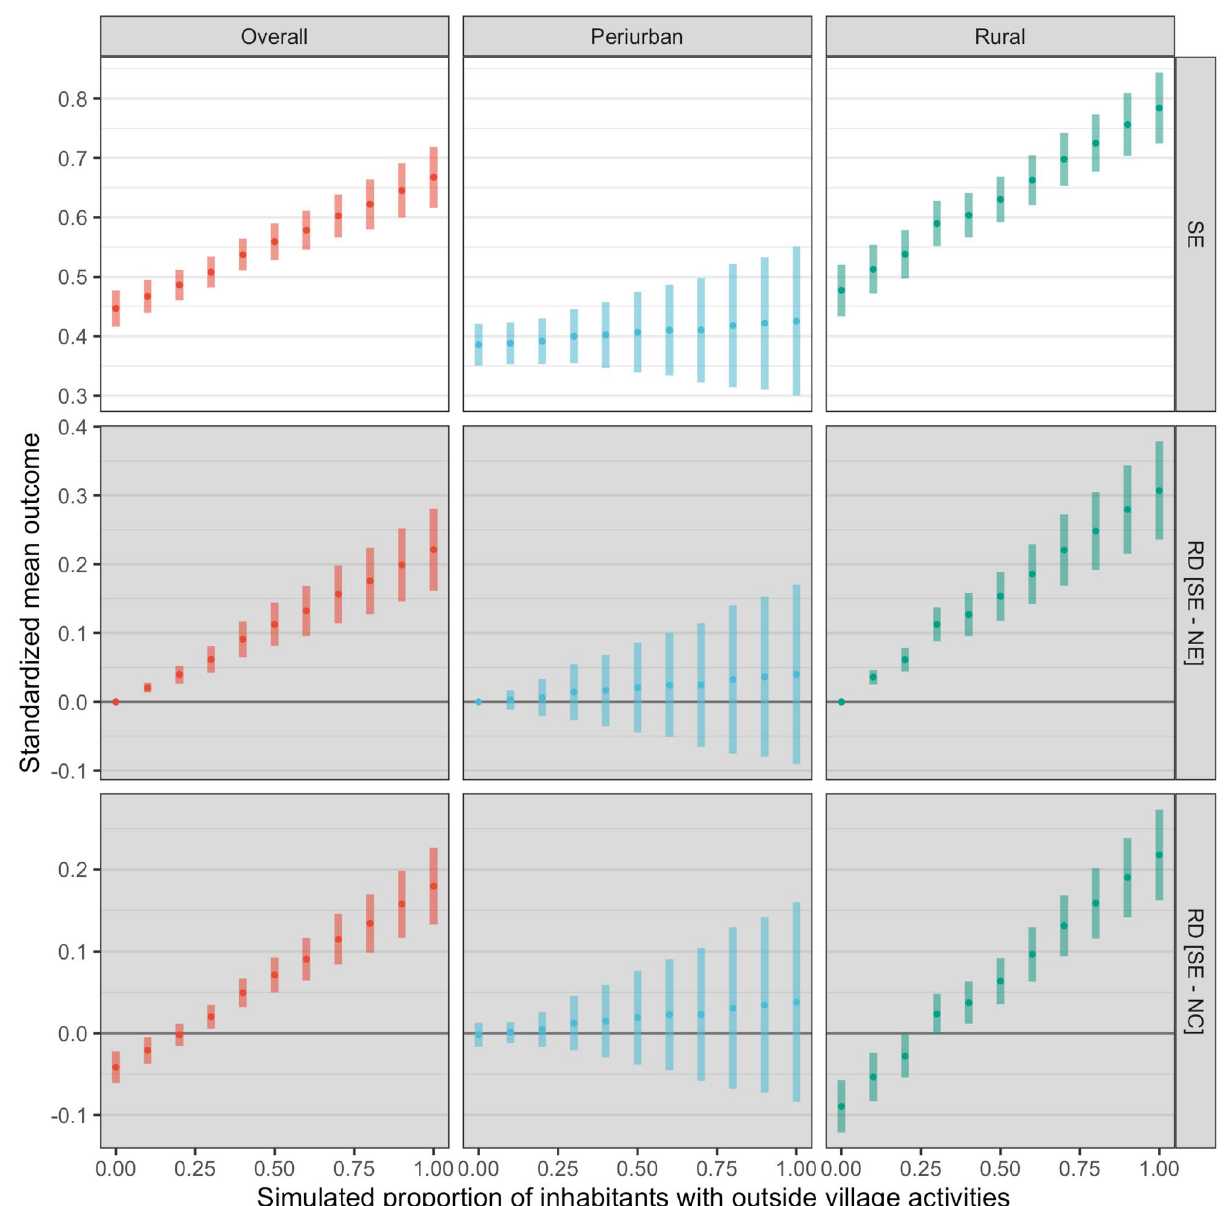
Figure 3. Standardized mean outcome estimated under simulated scenarios by proportion of travelers and geographic area in the Loreto department in the Peruvian Amazon. Standardized mean outcome estimations for the simulated exposure (SE; level of out-of-village working activities) and its risk difference (RD, grey panels) in comparison to no exposure (NE) and the natural course